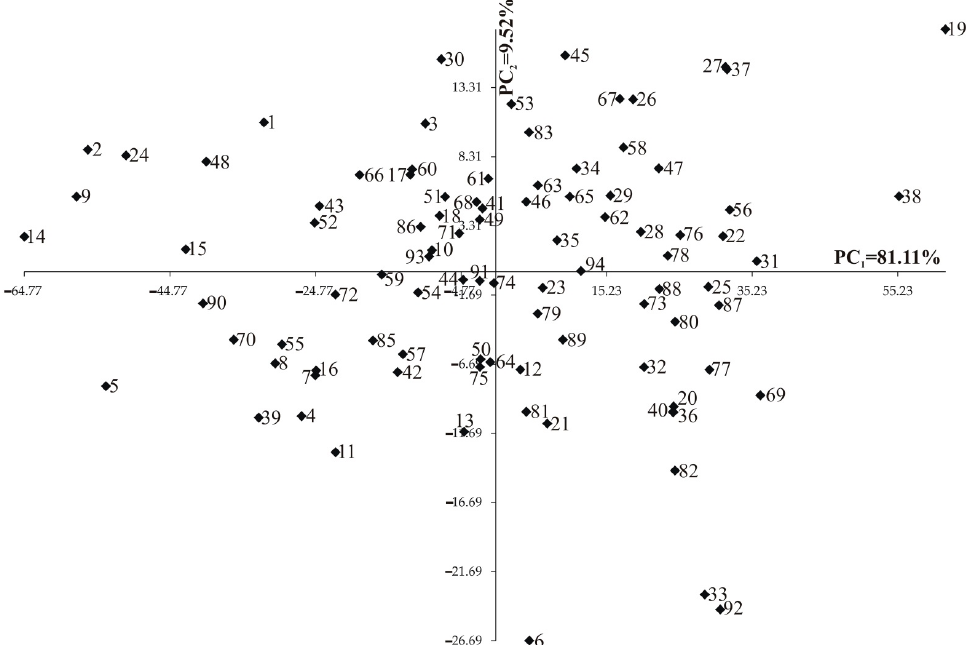
Figure 1. Population structure of inbred lines of maize ( Zea mays L.) estimated by eigenanalysis. Dent ID: 5,7,8,9,20,22,23,33,43,44,56,58,59,61,62,64,65,72,76,79,80,83,85,88,89,90,94; Dent BSSS: 47,49,50,87; Dent ID/BSSS: